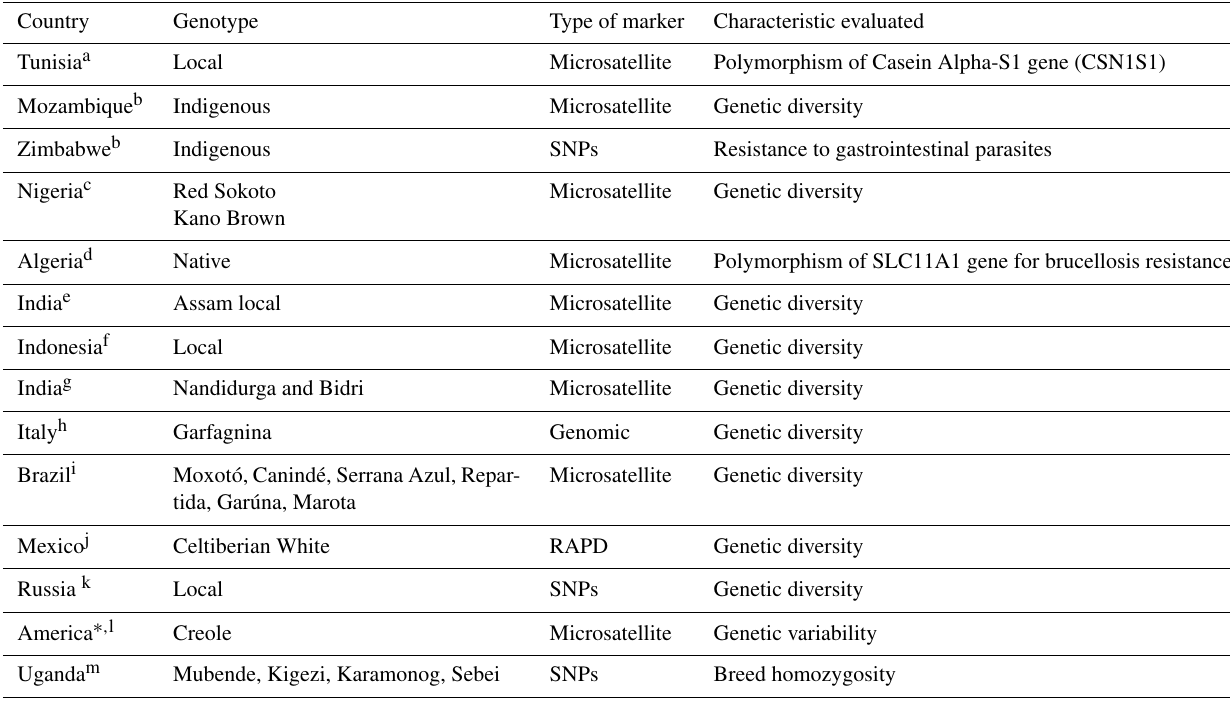
Table 3. Genomic–molecular studies carried out with local goats in various regions of the world.